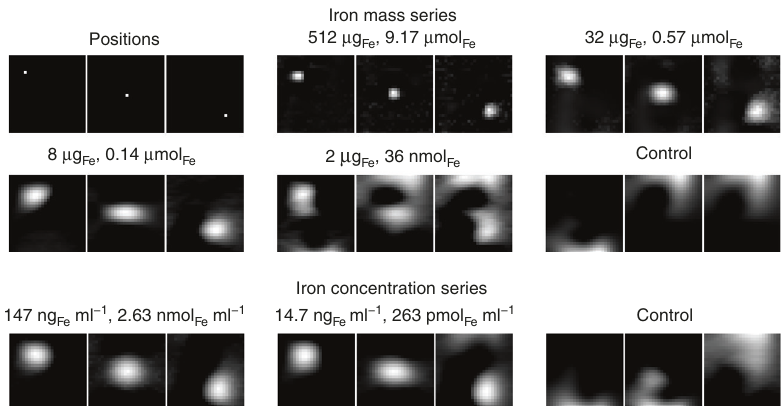
Fig. 2 Sensitivity of the developed MPI brain scanner. 50 μ l samples of Perimag with varying dilutions are moved to three positions on the FOV diagonal (upper 6 images). The sample is considered to be detected if the movement of the sample correlates to the signal shift in the image. Below 2 μ g Fe this correlation fails. The same procedure is done with an ellipsoid of 134 ml fi lled with different concentrations (lower 3 images). At a concentration